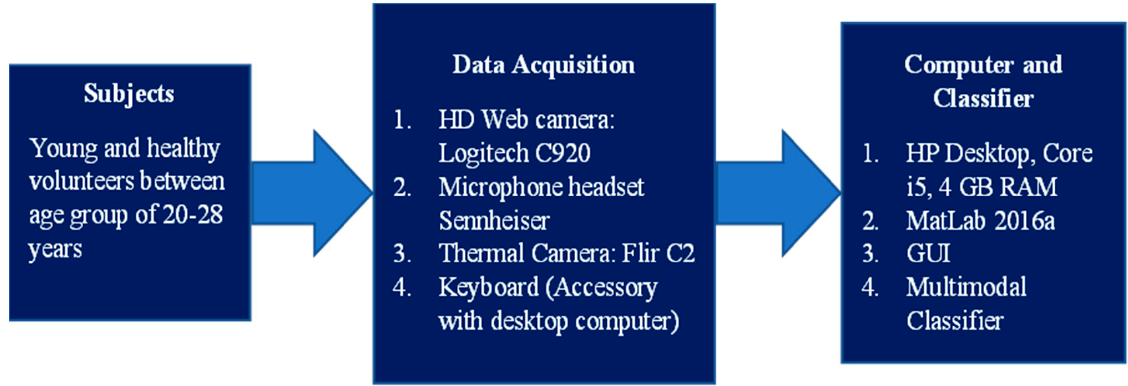
Figure 1. Demonstrating experimental apparatus.